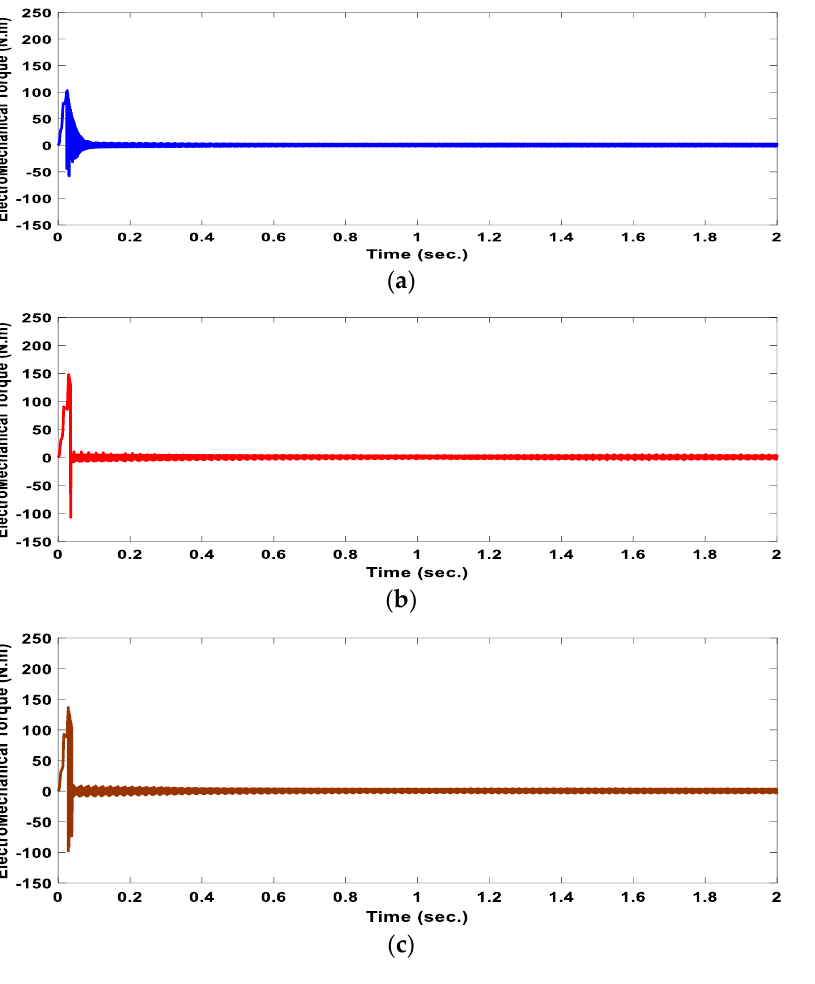
Figure 17. The motor-developed torque for the desired speed of 50 rad/s at zero load for a ( a ) PI-based PSO, ( b ) fuzzy PID based PSO, and ( c ) fuzzy-PID-based C-BO.